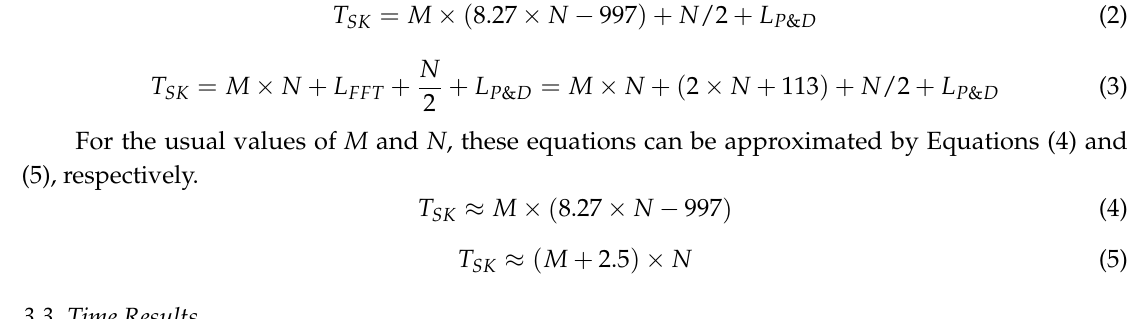
Figure 5. Elapsed time to calculate each iteration. ARM TM Cortex A7.